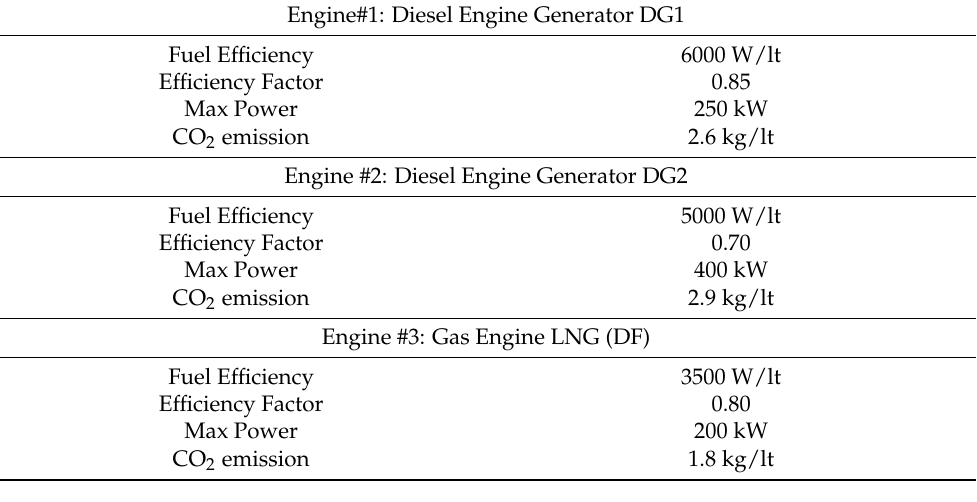
Table 4. Diesel Engines and LNG Engine Technical Data.